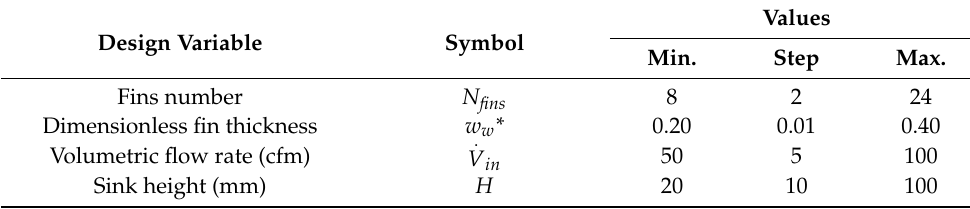
Table 1. Design variables